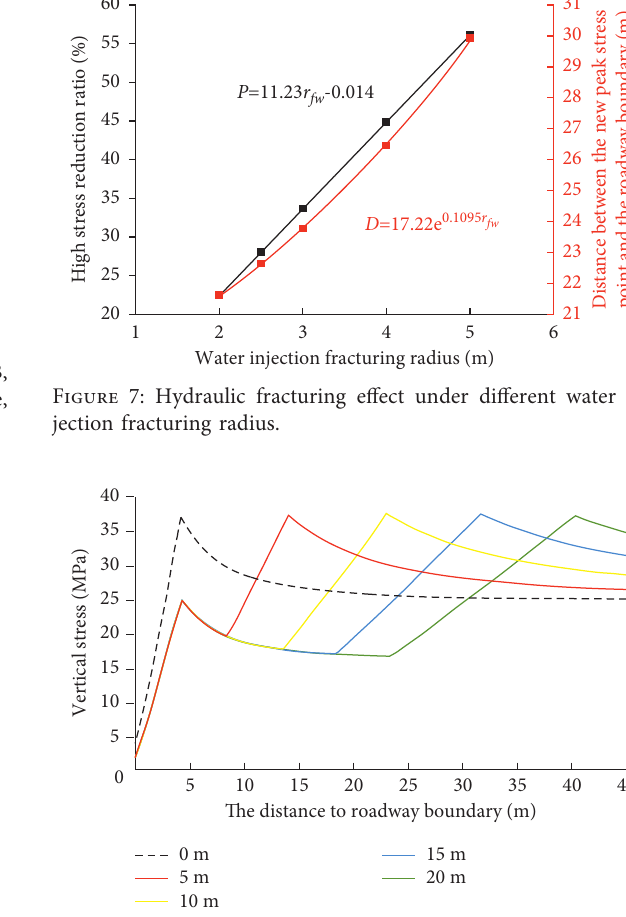
Figure 8: Vertical stress of roadway sidewall under different water injection section lengths.